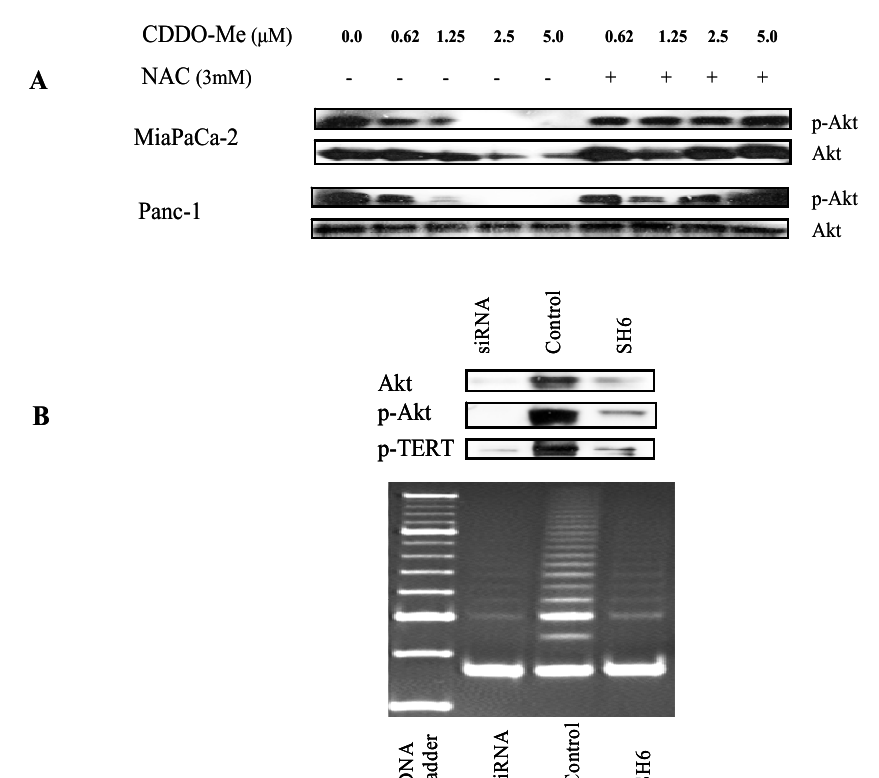
Figure 5. NAC blocks inhibition of p-Ak by CDDO-Me and inhibition of p-Akt inhibits telomerase activity of hTERT. ( A ) MiaPaCa-2 and Panc-1 cells were pretreated with NAC (3 mM) for 2 h followed by treatment with CDDO-Me (0–5 μ M) for 48 h. Cell lysates were analyzed for p-Akt and total Akt by western blotting; ( B ) Inhibition of p-Akt inhibits telomerase activity. Panc-1 cells were transfected with siRNA-Akt or treated with Akt inhibitor SH6 before treating with CDDO-Me (0–5 μ M) for 48 h. Cell lysates were analyzed for Akt, p-Akt and p-TERT by western blotting and telomerase activity was measured by TRAP